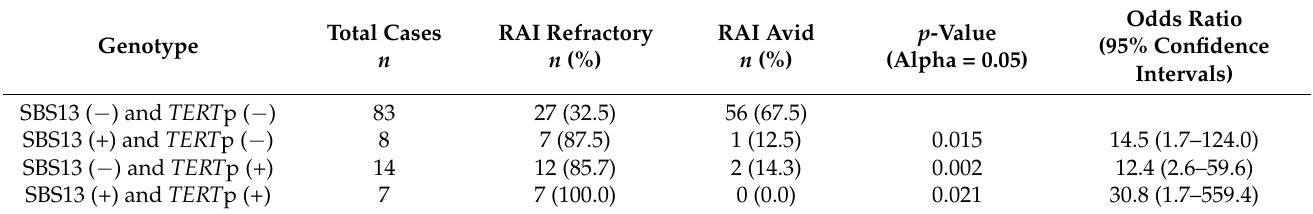
Table 2. Relationship between the APOBEC SBS13 mutational signature alone, TERT promoter ( TERT p) mutation alone, their co-occurrence, and radioactive iodine (RAI)-refractoriness in